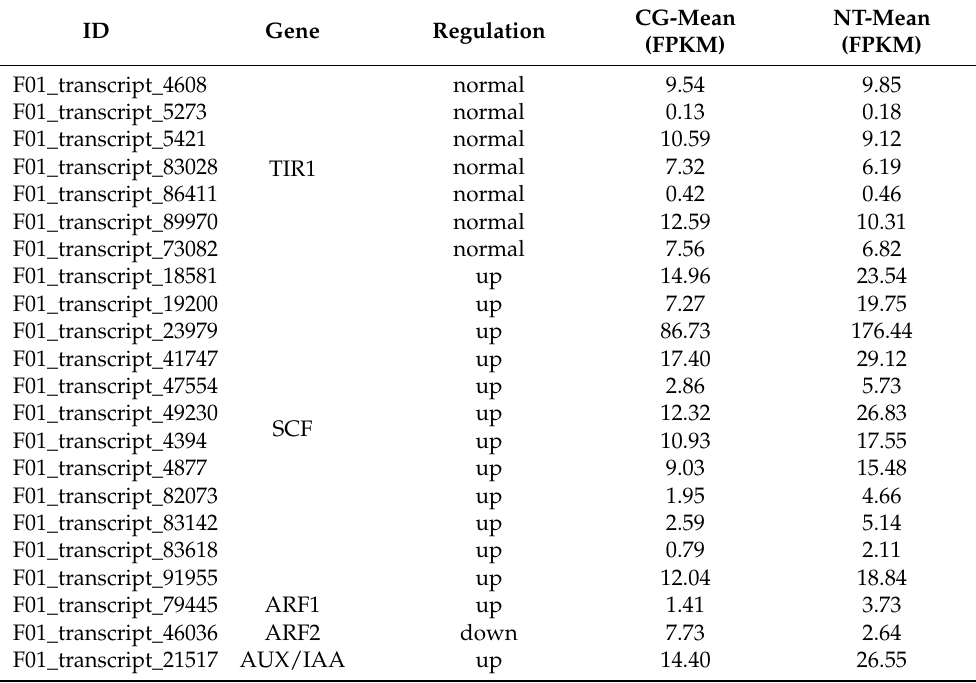
Table 5. TF genes for auxin signal transduction pathway and their expression